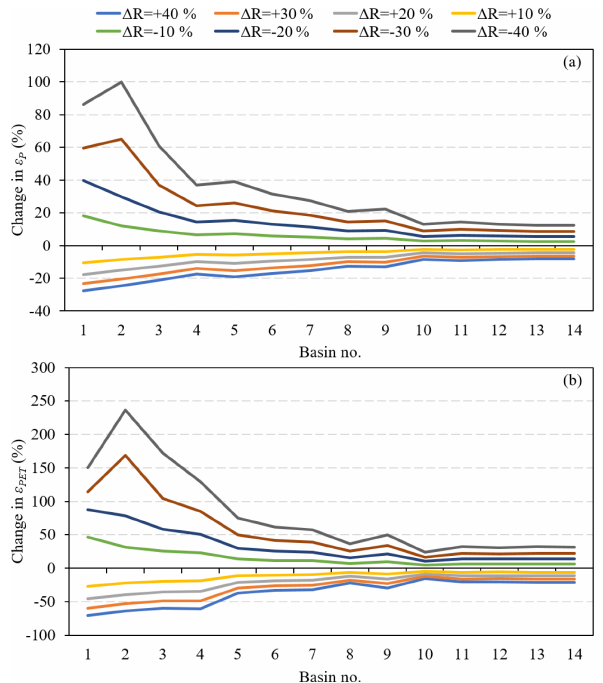
Figure 14. Comparison of changes in (a) P elasticity and (b) PET elasticity in response to changes in R for the 14 river basins of China. The basin number is consistent with that given in Fig.